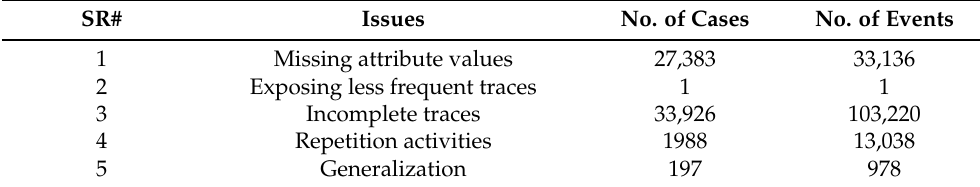
Table 8. Evaluation of event log issues in the procurement process.